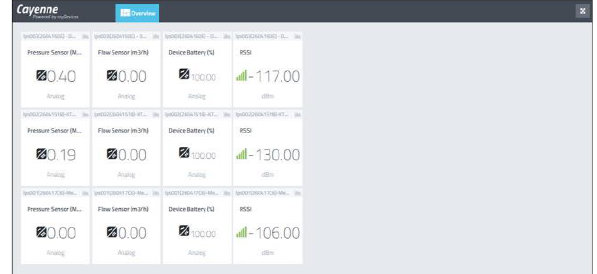
Figure 8. Real-Time Data in interval 10 minutes.